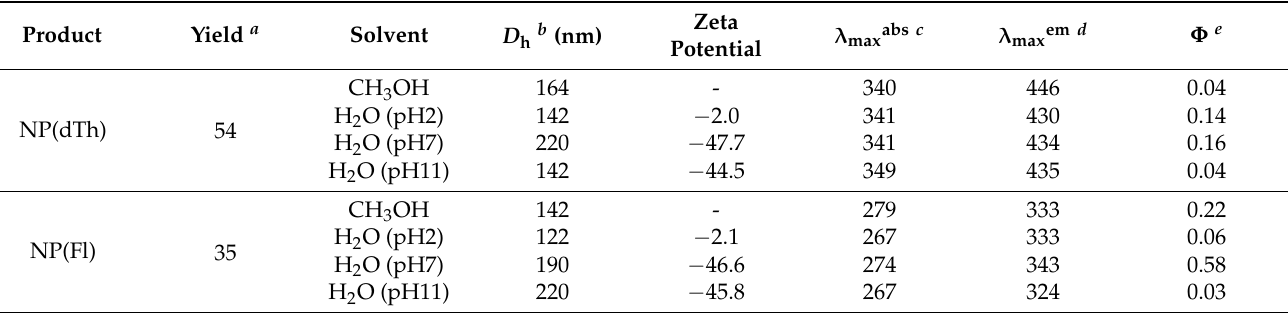
Table 1. Synthesis and characteristics of NPs.